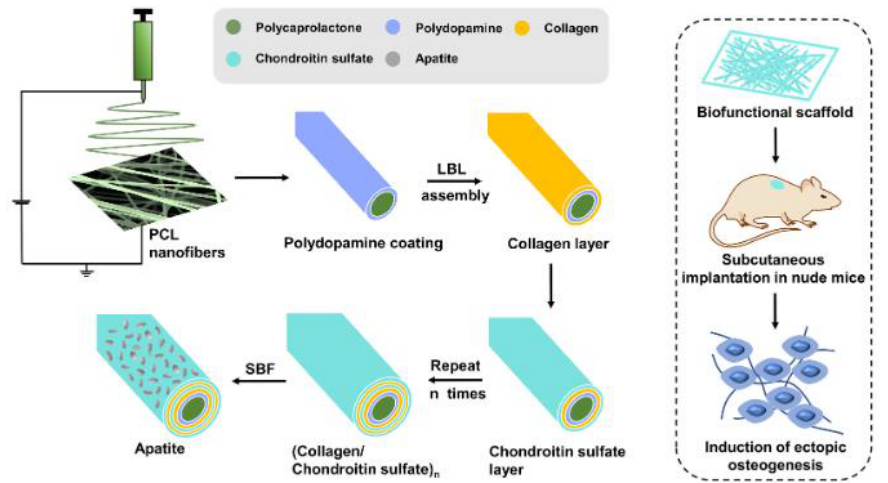
Figure 6. Schematic of the biofunctional bone scaffold fabrication with LBL self-assembly on electrospun fiber membranes followed by apatite deposition (reproduced with permission after [230] ).